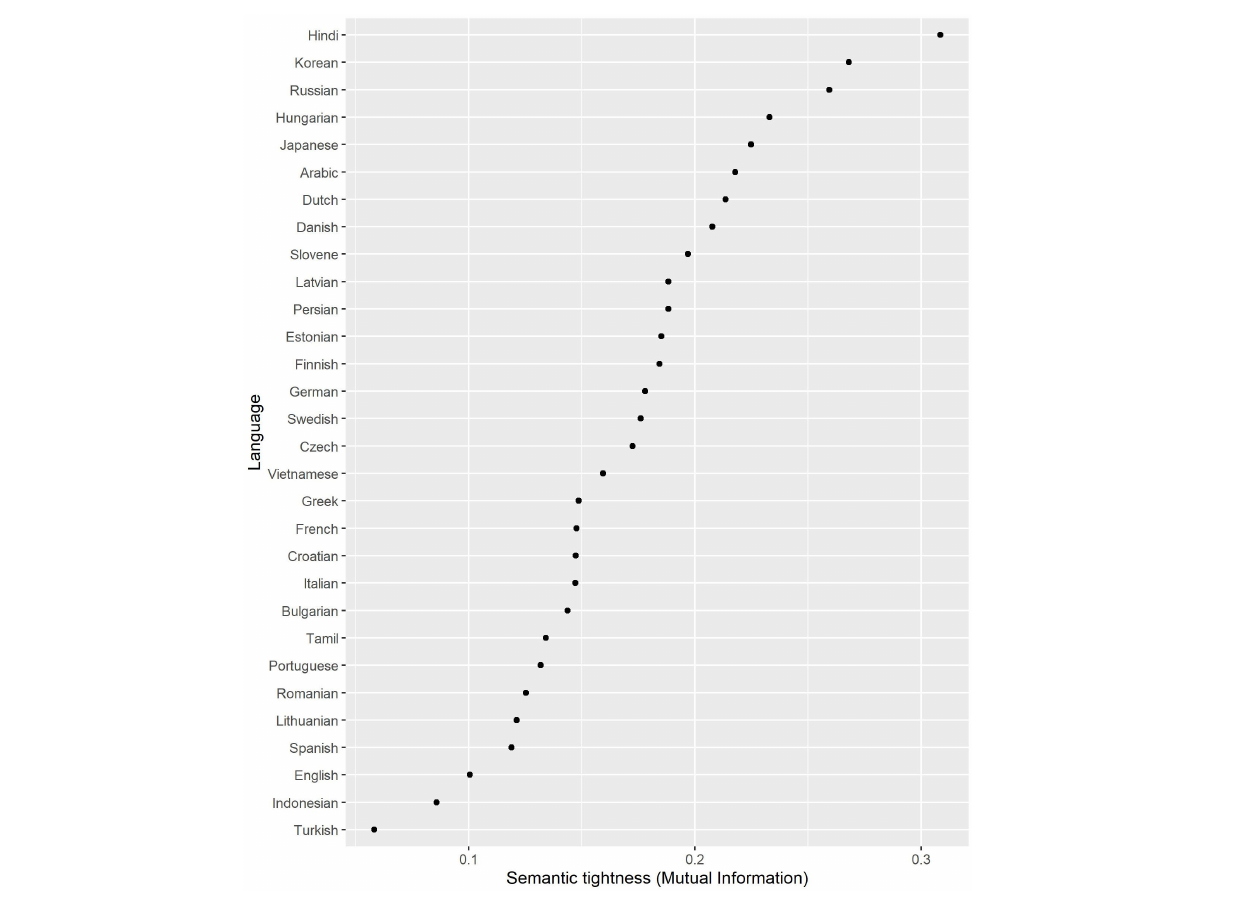
FIGURE 2 | Semantic tightness (Mutual Information between Role and